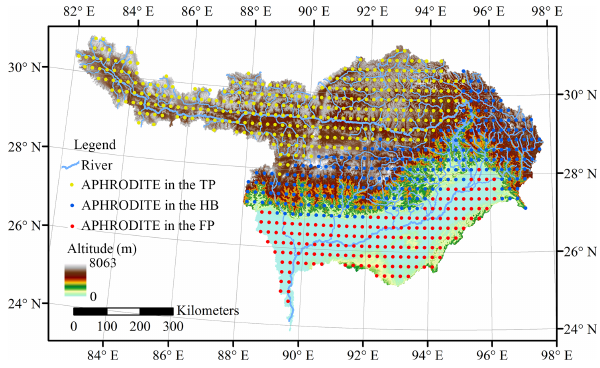
Figure 2. Location of Asian Precipitation Highly Resolved Obser- vational Data Integration Towards Evaluation of Water Resources (APHRODITE) grids over the Tibetan Plateau (TP), Himalayan belt (HB), and floodplains